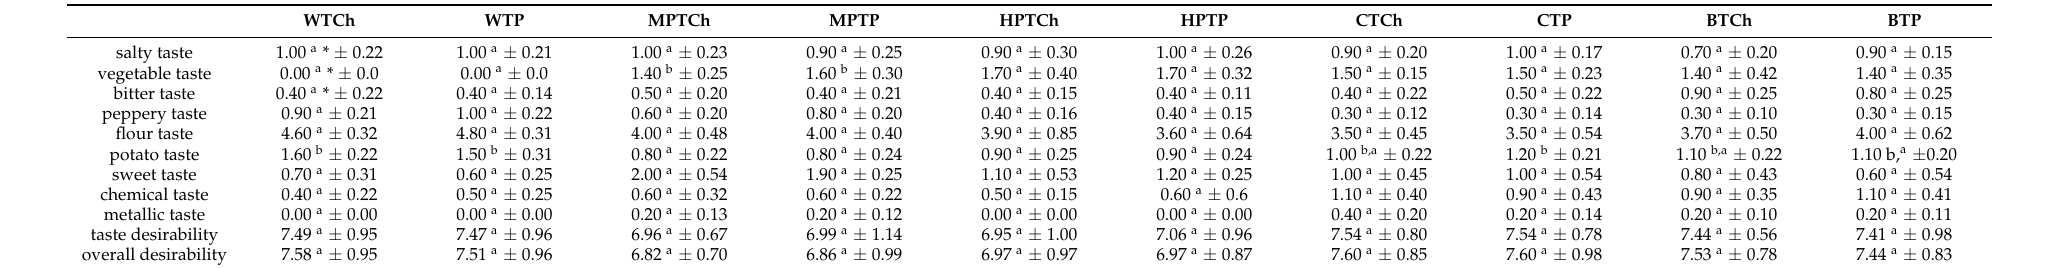
* Different letters denote a significant difference for means ( n = 14), at a α ≤